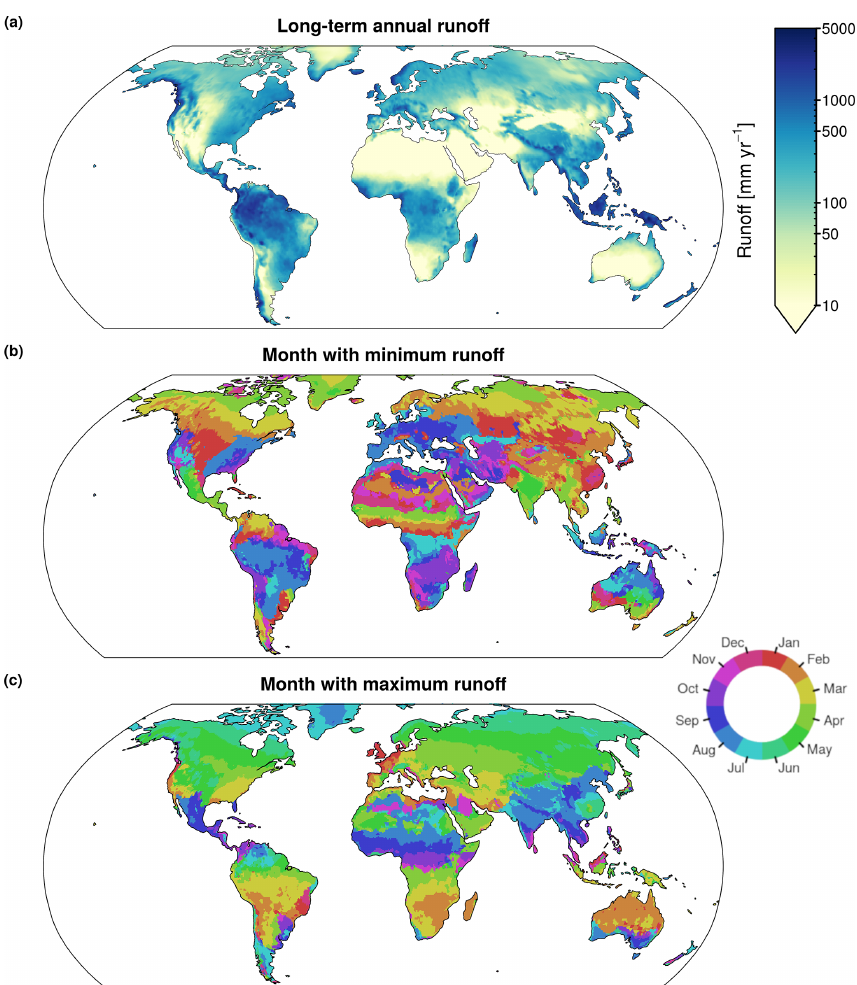
Figure 9. Runoff climatology (1902–2014). (a) Long-term mean annual runoff rates. (b) Month with the minimum and (c) the maximum long-term mean monthly